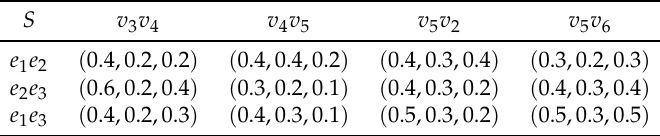
Table 6. Neutrosophic soft relation S . Table 6: Neutrosophic soft relation S